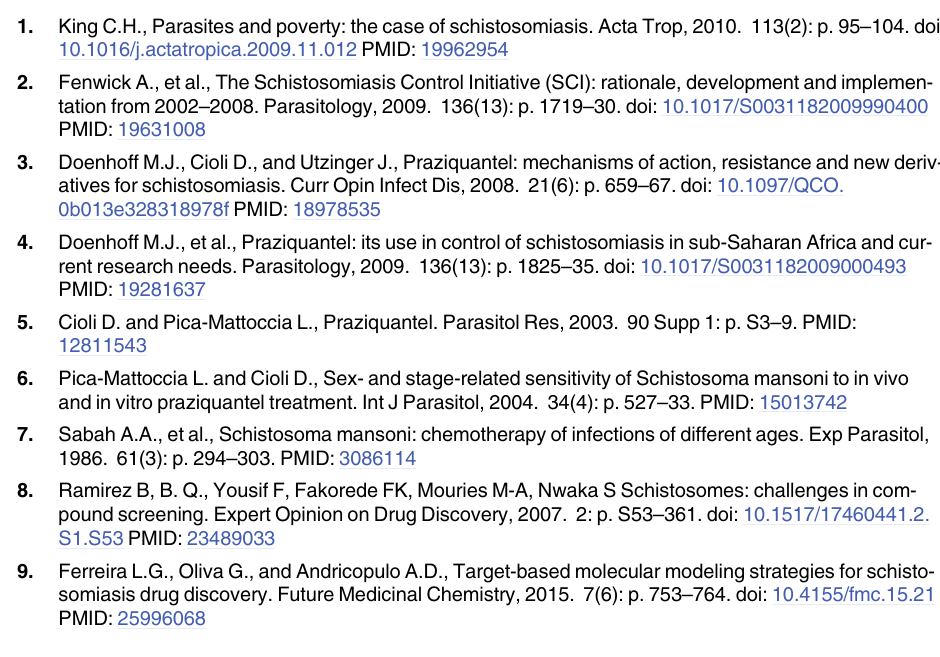
S1 Table. Table of additional actives obtained during the screening. These structures were deprioritised relative to those in the body of the paper for the reasons given in the comment column. The assays are those described in the paper. ND = No data obtained. S2 Table. This table lists each of the structures in the paper (and a couple described in S1 Table) and then a summary of findings obtained using the KNIME workflow ‘ Know Your Molecule ’ to access and present ChemBl data as described in the paper. The structures shown are those with similarity to the compound number listed in column 1 of the